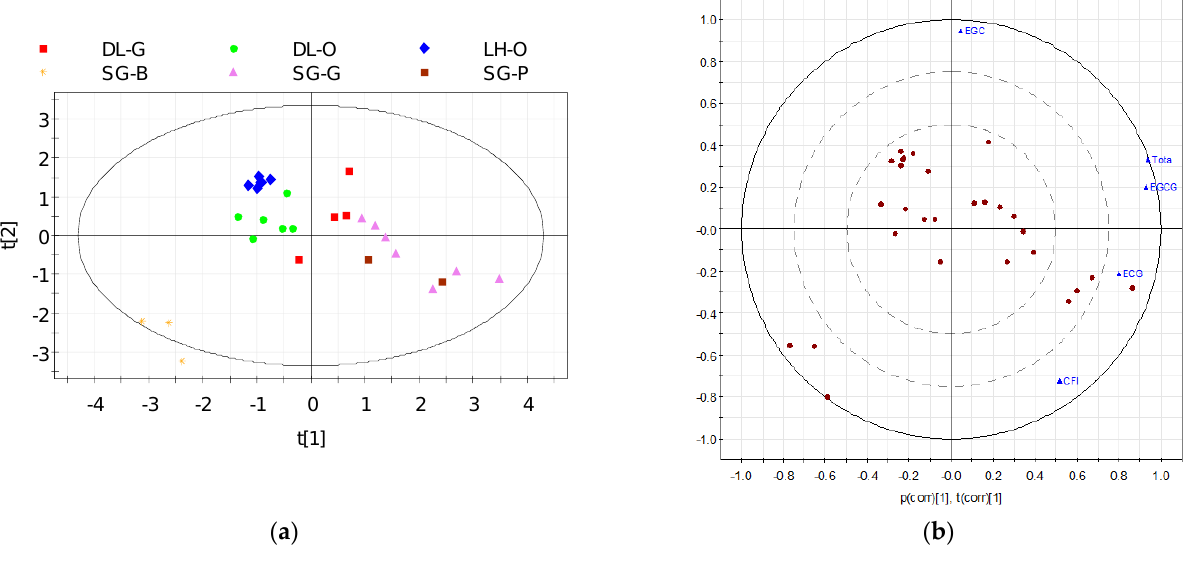
Figure 3. The PCA scores ( a ) and Biplot graph ( b ) of the first two principal components for 28 tea samples in Vietnam based on 5 variables (CFI, EGC, EGC, EGCG, and total catechins) with 85.3% of the cumulative variance of two first components.